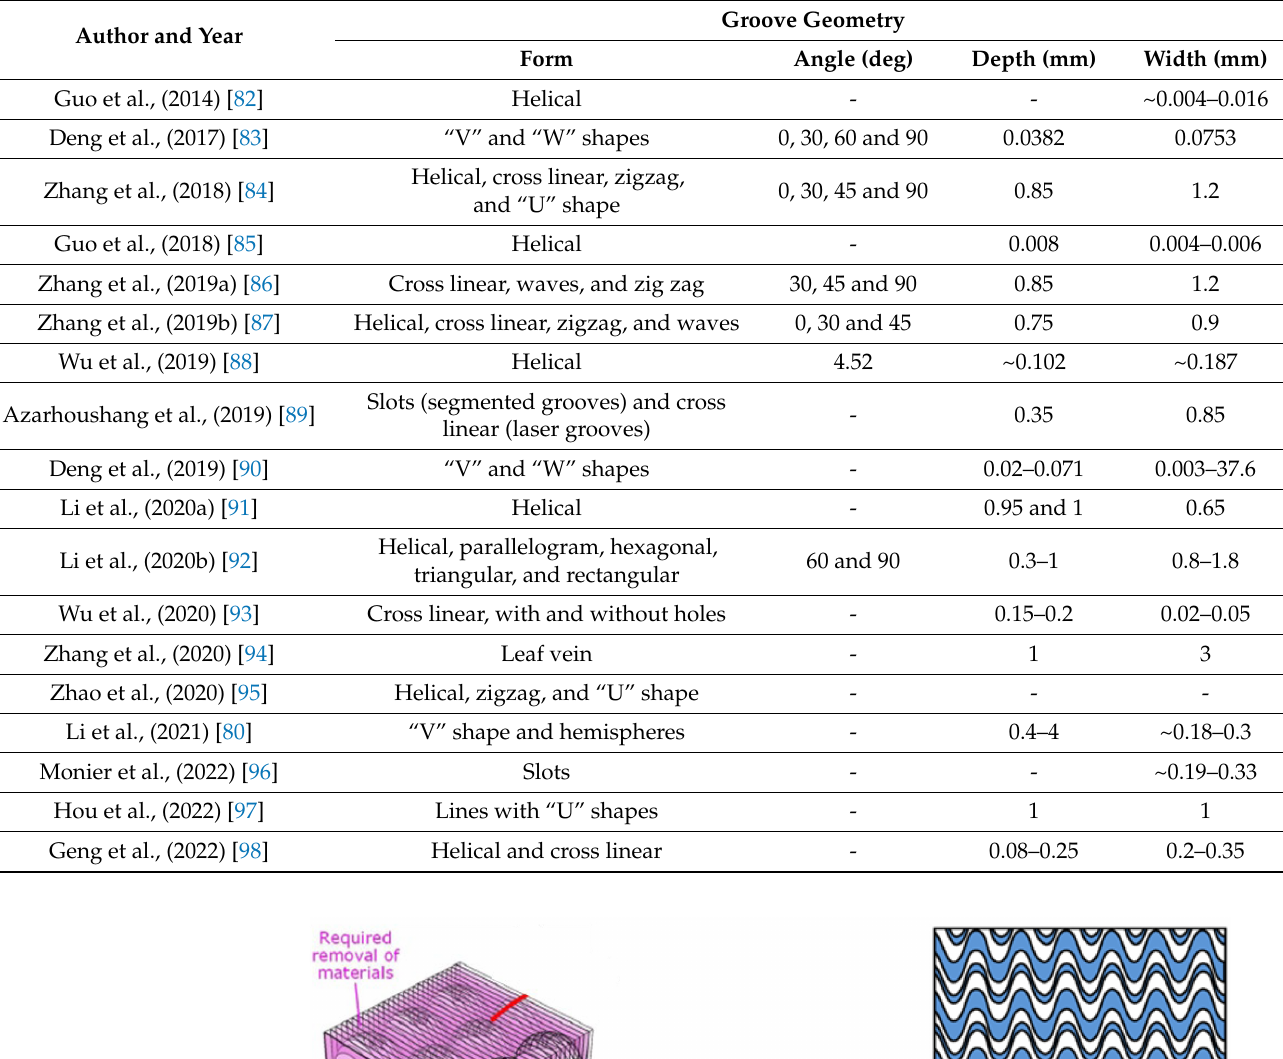
Table 6. Laser groove geometries and dimensions.